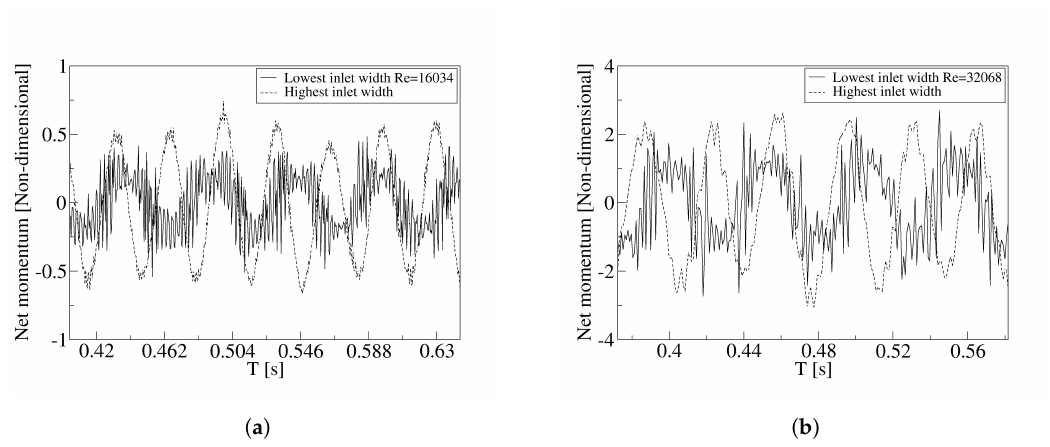
Figure 17. Net momentum acting on the fluidic oscillator inlet jet and for two different mixing chamber inlet widths (the lowest and the highest), two different Reynolds numbers, 16034 Figure ( a ) and 32068 Figure ( b ), were